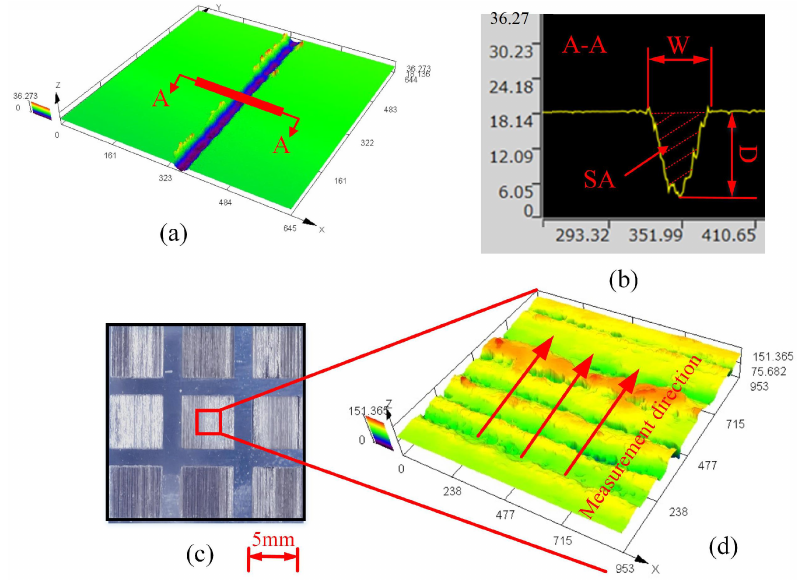
Figure 4. Schematic of machining results and measurement process. ( a ) Typical micro-groove diagram observed by LEXT OLS5100. ( b ) Section profile of the micro-groove. ( c ) Physical image of the rough surface after plane scanning. ( d ) Typical surface morphology observed by LEXT